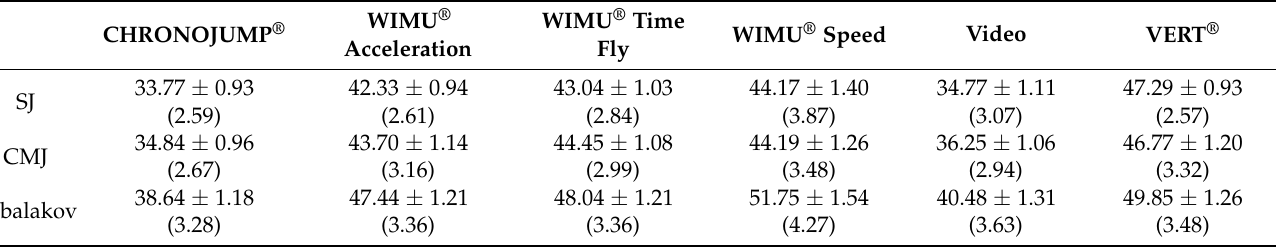
Table 1. Jump height calculated by mean ± standard error of the mean and (minimum detectable change).